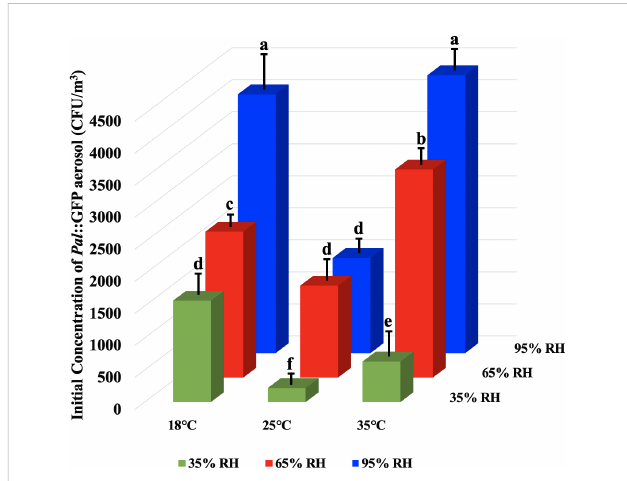
FIGURE 2 Effect of temperature and relative humidity (RH) on the initial concentration of Pseudomonas amygdali pv. lachrymans ( Pal ) in aerosols after aerosolization. Pal ::GFP suspension (10 8 CFU/mL) was aerosolized to nine aerosol chambers, which maintained at 18, 25 and 35°C with three humidity levels of 35%, 65% and 95% RH per temperature, respectively, and the initial concentrations of Pal ::GFP in aerosols were examined 0 min after nebulization. The experiments were independently repeated three times. Columns and error bars represent the mean values and standard deviations (SDs) of three replicates. Columns labeled with different letters indicate statistically signi fi cant differences ( p <